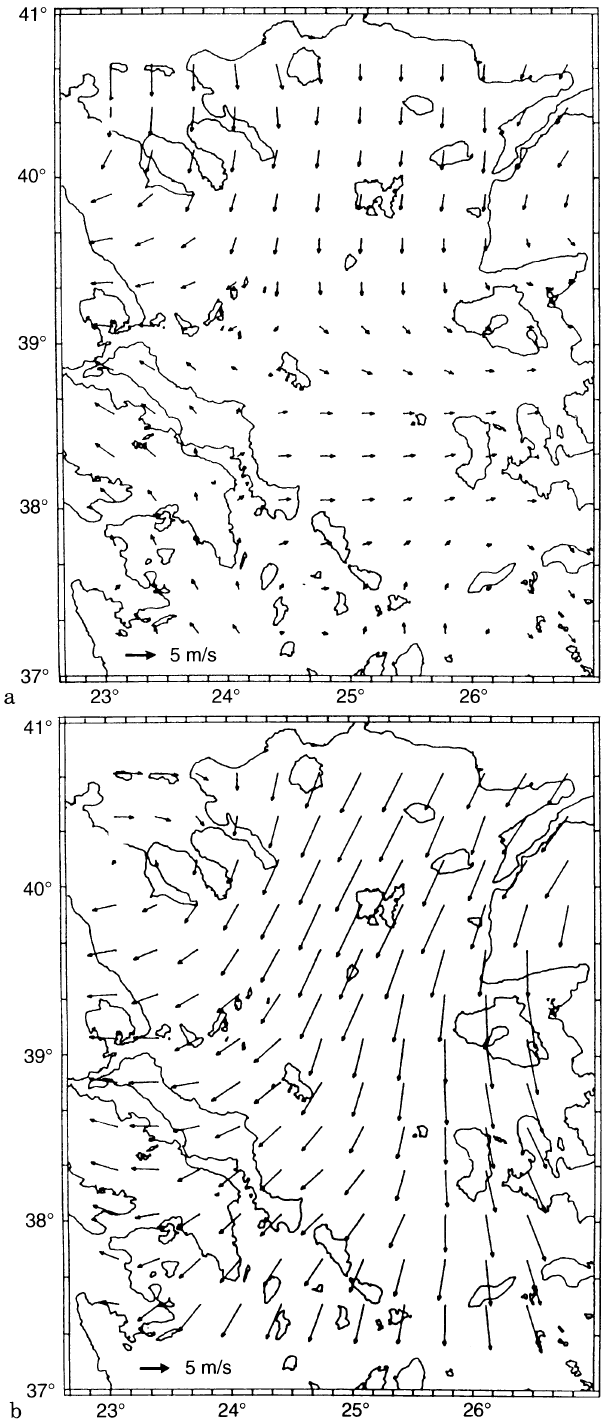
Fig. 8a,b. Wind speed fields (ms (cid:126)(cid:49) ) over the North Aegean Sea; a for 28 June 1993; b for 02 July 1993